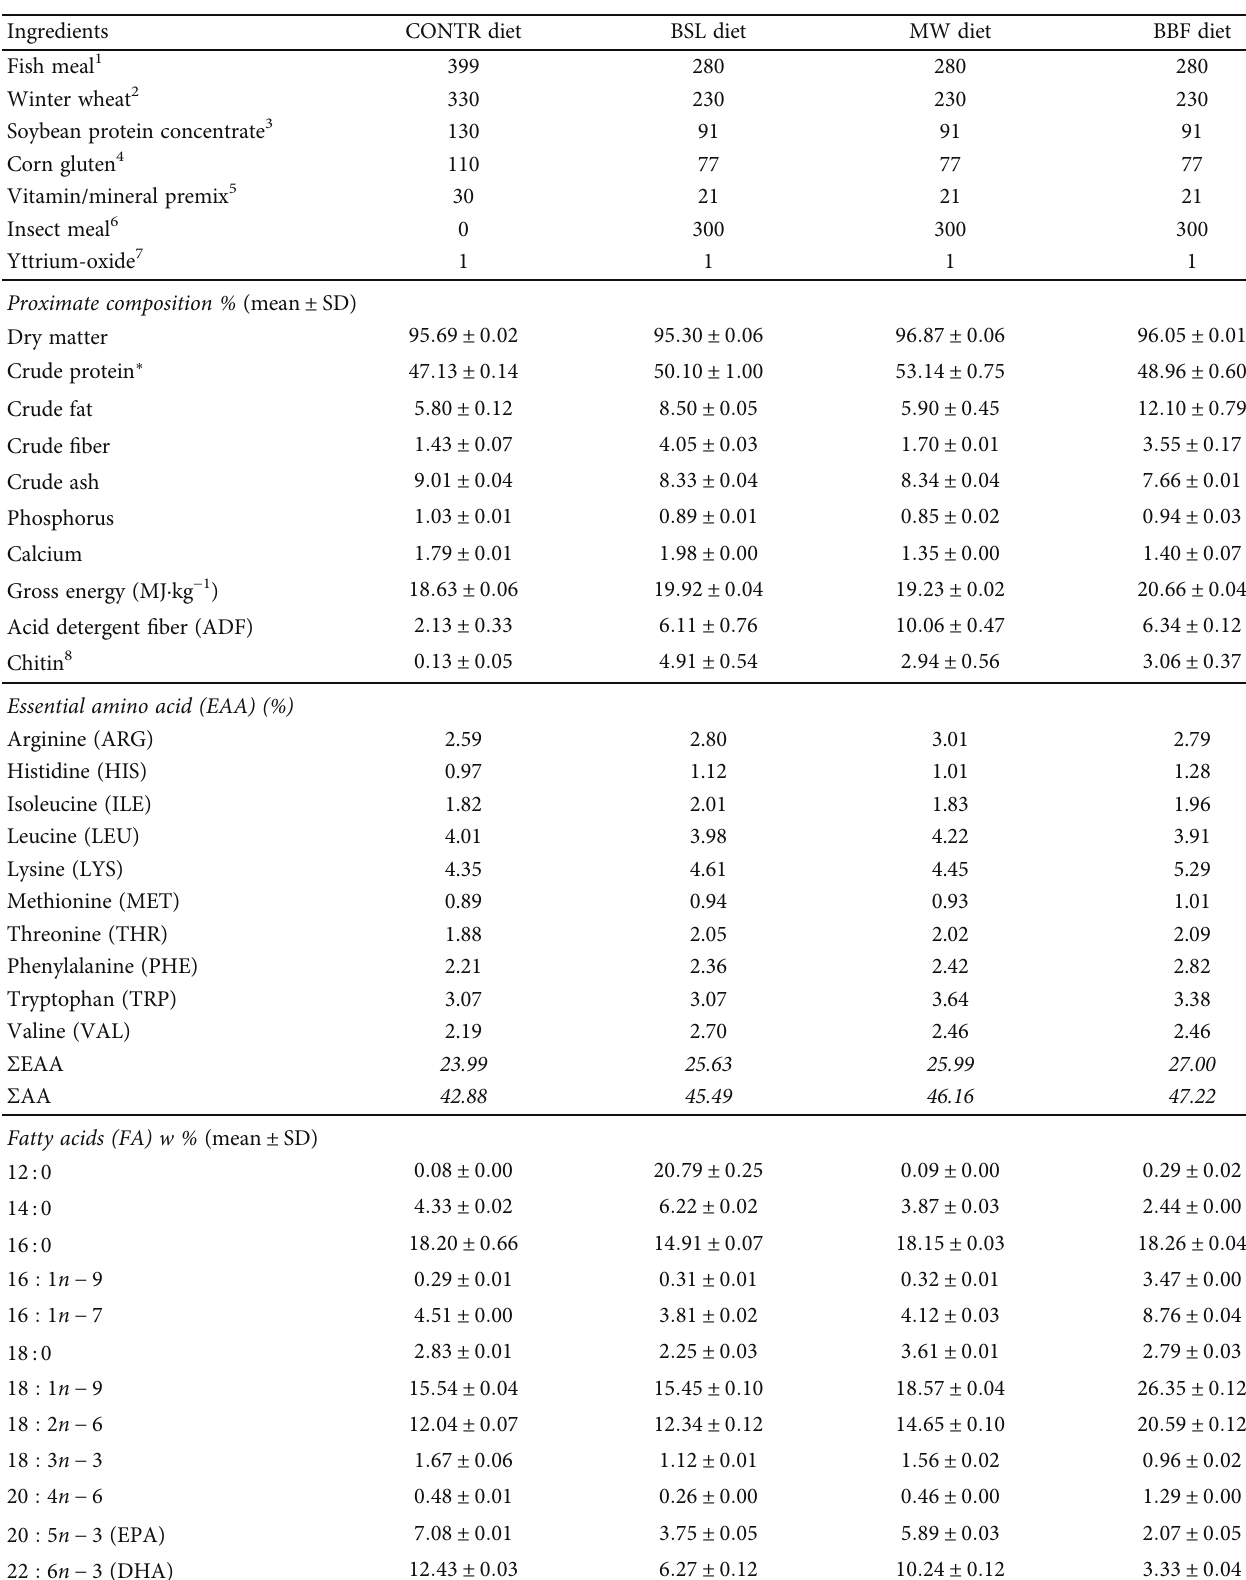
Table 2: Formulation (g · kg − 1 ), proximate composition (%, wet weight), gross energy (MJ · kg − 1 , wet weight) amino acid and fatty acid pro fi le (w %) of the control, and experimental diets used in the digestibility